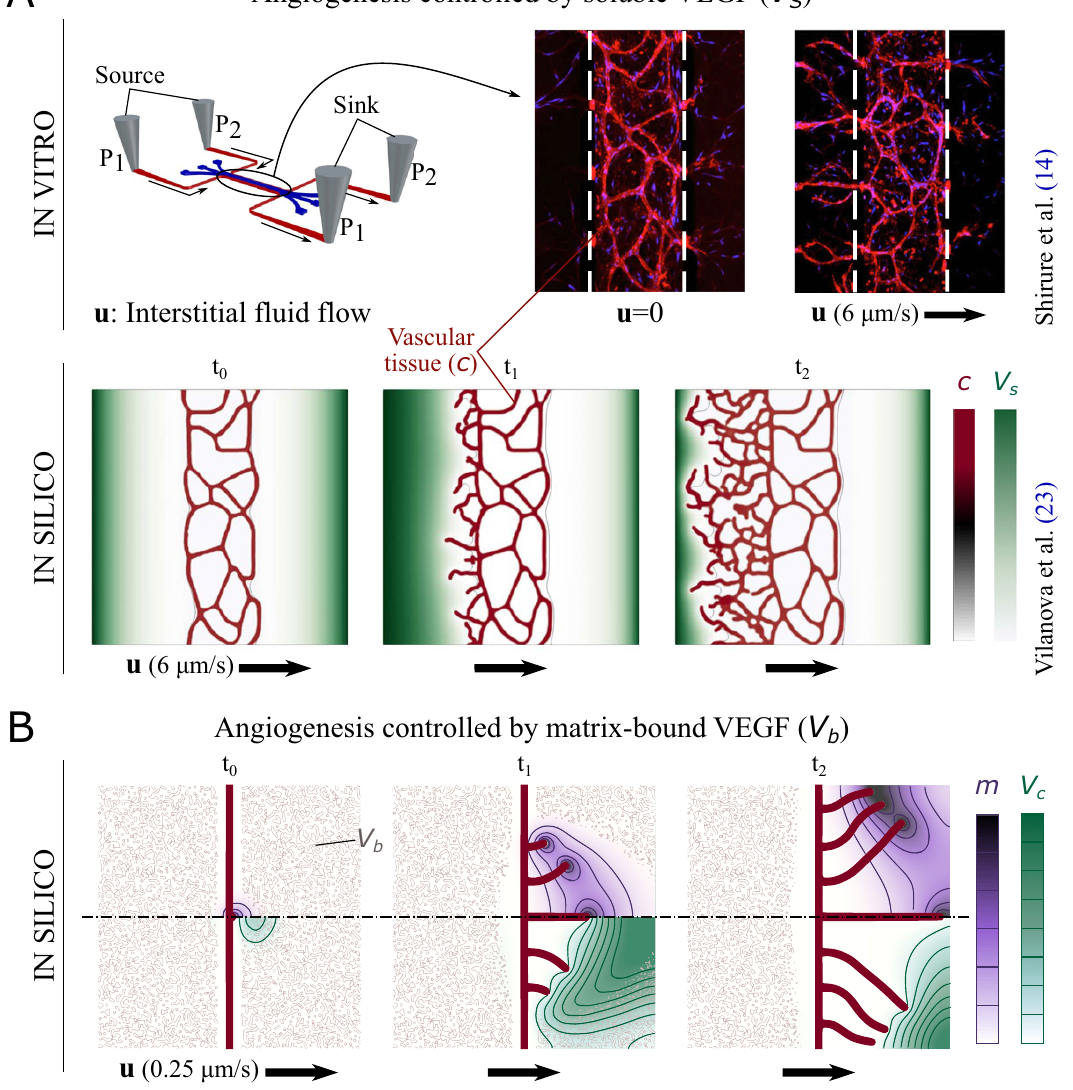
Figure 1. Flow-mediated angiogenesis controlled by ( A ) unbound and ( B ) matrix-bound isoforms of vascular endothelial growth factors (VEGF). Black arrows represent the interstitial flow u . (A) In vitro 14 and in silico 23 investigation showed that interstitial flow changes the spatial distribution of unbound (or soluble) VEGF via convective transport. Gradients of soluble VEGF ( V s ) are steeper in the opposite direction to the interstitial flow, which induces preferential vascular growth against the flow. Adapted from Shirure et al. 14 and Vilanova et al. 23 . (B) When VEGF is initially bound to the matrix, the proteolytic activity of matrix metalloproteinases (MMPs, secreted by tip cells) is required to cleave the matrix-bound growth factors, which transform into soluble isoforms denoted as cleaved VEGF. Our model shows that the combined transport of MMPs ( m , top half) and cleaved VEGF ( V c , bottom half) produces positive gradients of cleaved VEGF in the direction of the flow near the tip cells, which induce preferential capillary growth with the flow. Top and bottom halves of the plot correspond to the same